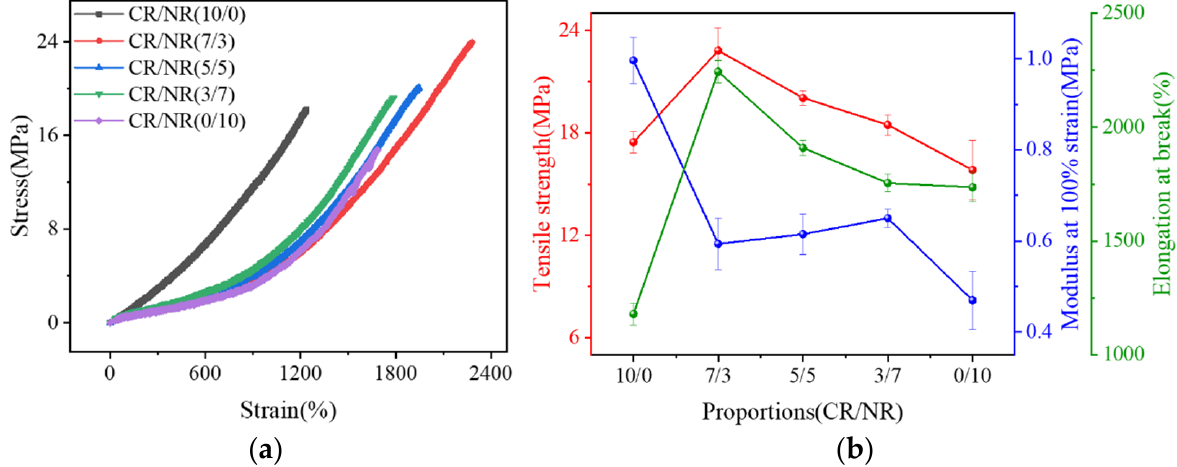
Figure 3. Stress–strain curves of CR/NR blend with different blending ratios ( a ) and their tensile strength, modulus, and elongation at pull − off ( b ).